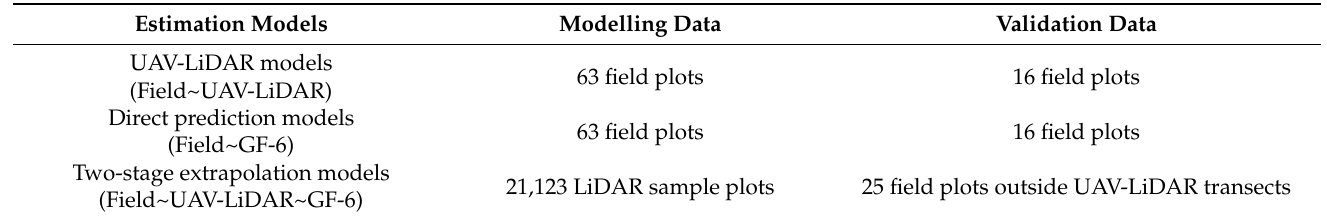
Figure 4. The variable importance of forest structural parameters was calculated for the UAV-LiDAR- and GF-6 satellite imagery-derived metrics using the Boruta algorithm analysis. Table 4. Summary of modeling and validation plots of four forest structural parameter estimation